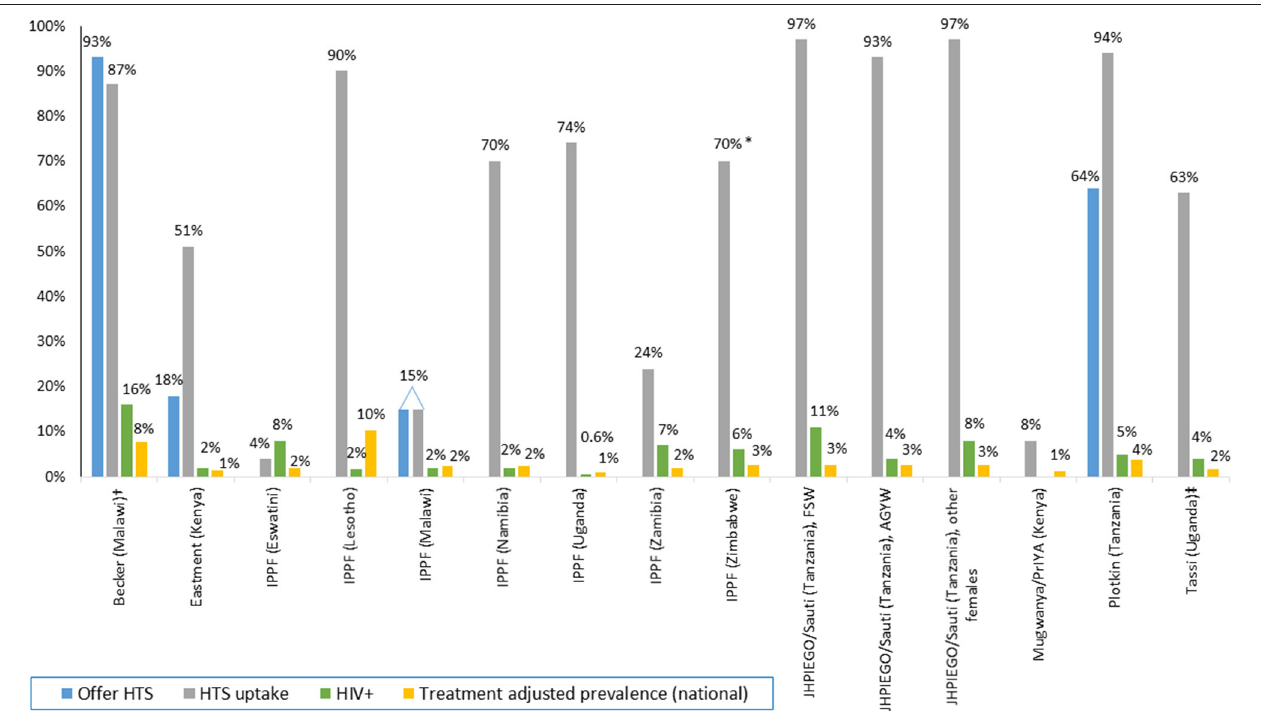
FIGURE 2 | HTS offered, uptake, and positivity among integrated FP programs, by program. Data presented in the figure are rounded to the nearest whole number if it is > 1%. Adolescent girls and young women (AGYW); female sex worker (FSW); HIV testing services (HTS); International Planned Parenthood Federation (IPPF). *Range 70–95%. † HTS offer and uptake among male–female couples, HIV positivity among women only. ‡ Sex not specified.